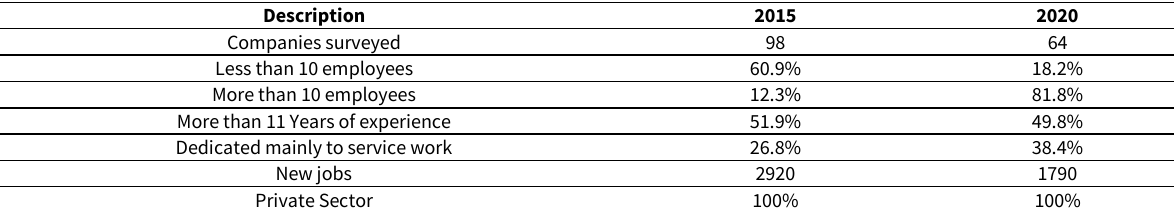
Figure 1. Distribution and geographical location of ITS developer companies in Puerto Rico. (a) the year 2020, (b) the year 2015 Table 1. General profile of the companies